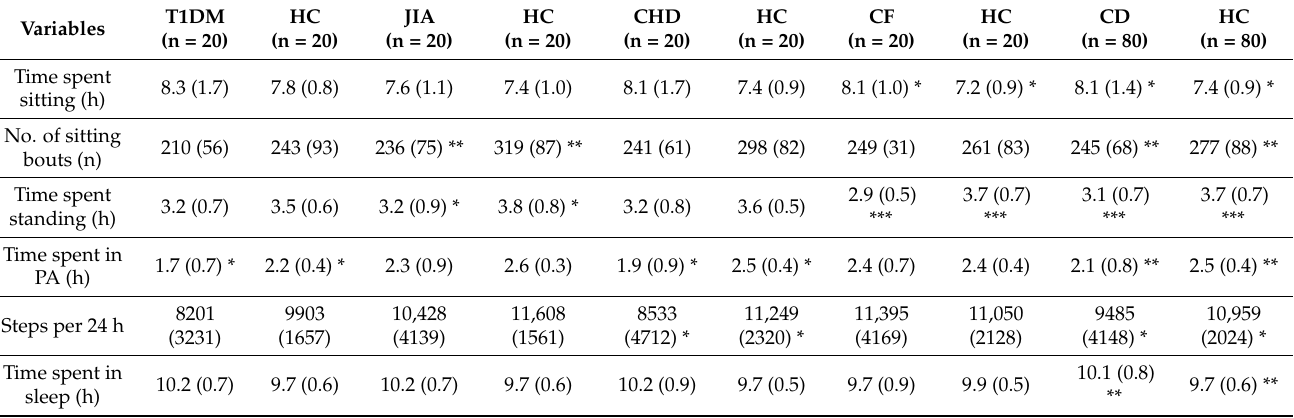
Table 2. 24-h movement behavior variables in children with chronic disease and their healthy control groups; data are presented as means and